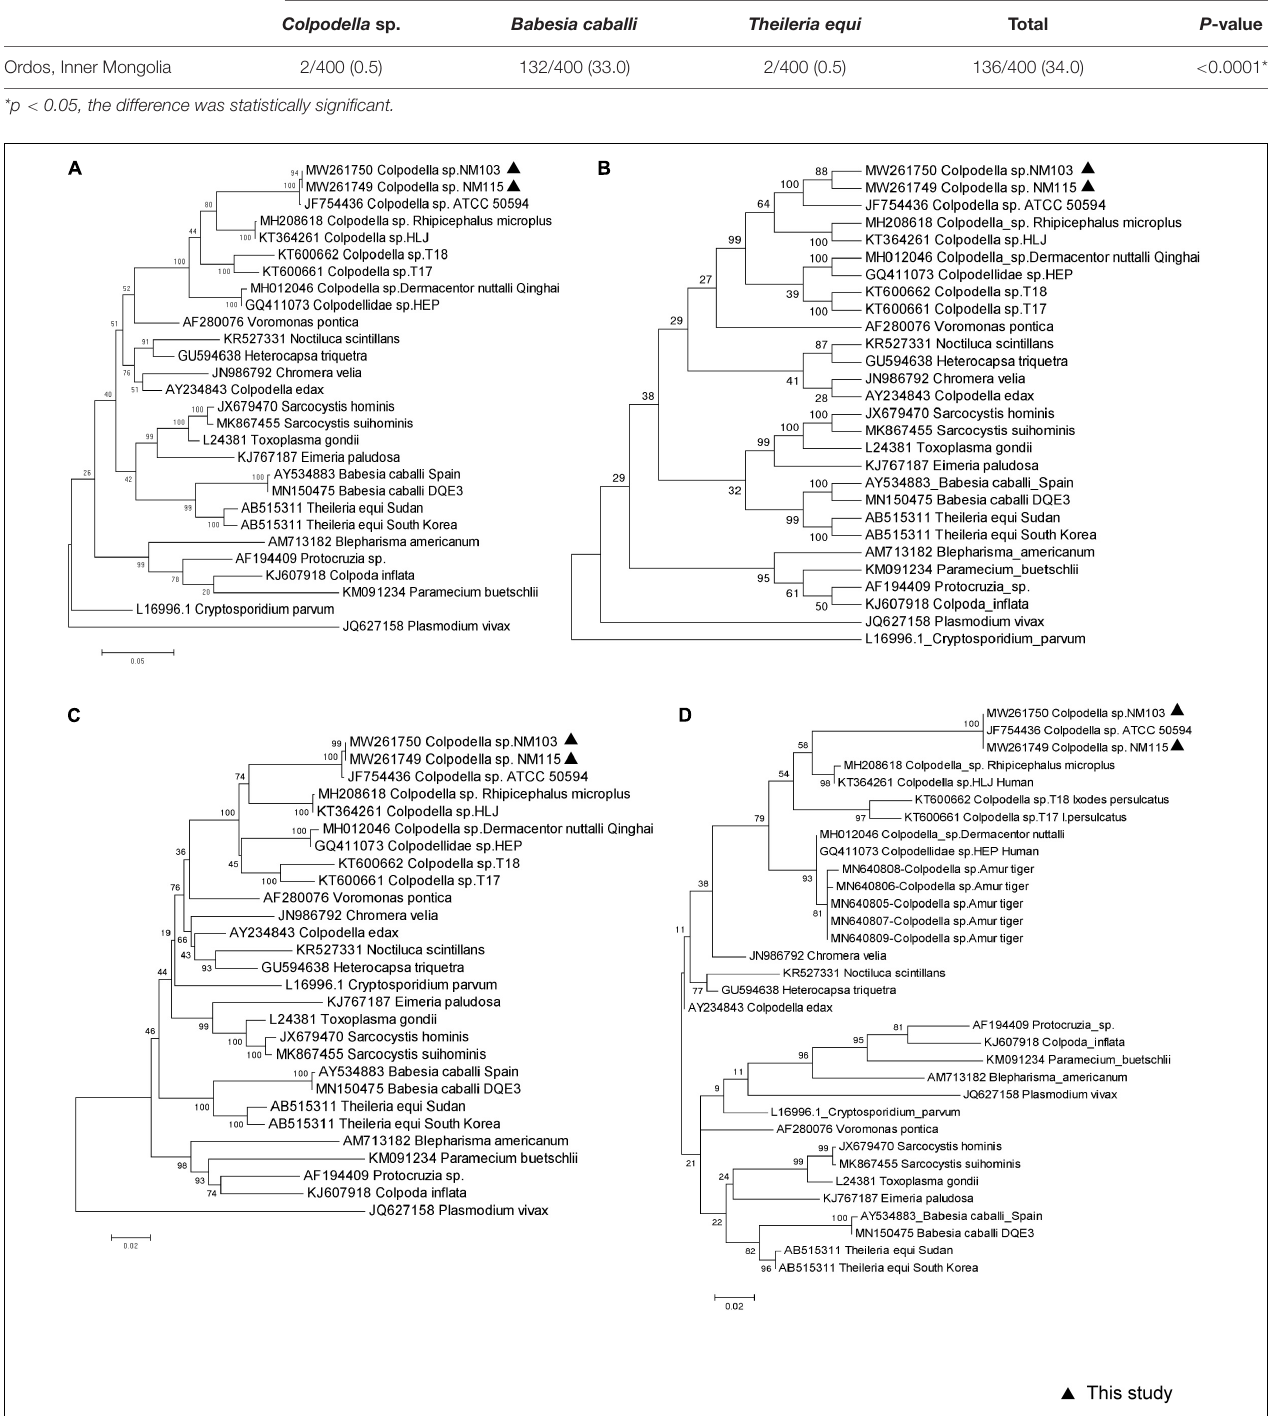
FIGURE 2 | Molecular phylogenetic analysis of piroplasma from horse based on 18S rRNA sequences. Three methods were used to construct a phylogenetic tree, which are (A) Maximum-Likelihood Tree, (B) Maximum Parsimony Tree, (C) Neighbor Joining Tree based on near entire 18S rRNA sequences, respectively. (D) Maximum-Likelihood Tree based on 583 bp partial 18S rRNA sequences. All reference sequences show GenBank number and pathogen name, in which the sequence of this study is marked with a black triangle.